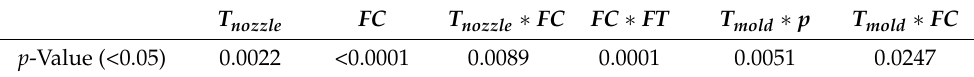
Figure 6. ( a ) Impact strength of wood-filled TPU as a function of fiber content and fiber type. ( b ) Impact strength of wood-filled TPU as a function of temperature control. Table 4. p -values of various test parameters for notched impact